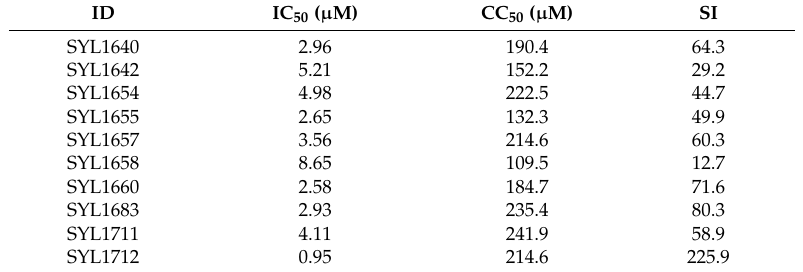
Table 2. CC 50 (A549), IC 50 (anti-HIV-1/EBOV) and SI values of 10 selected quinoline